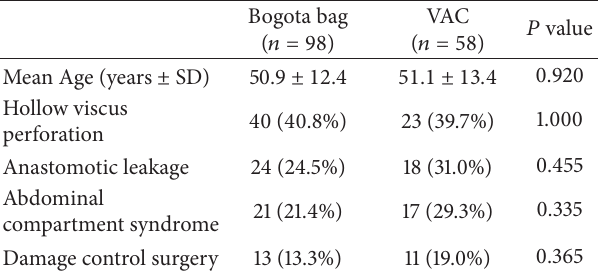
Table 1: Characteristics.